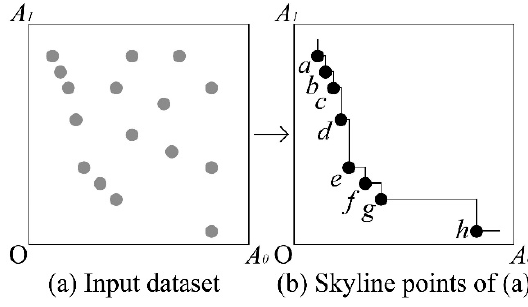
Figure 1. An example of computing skyline points.